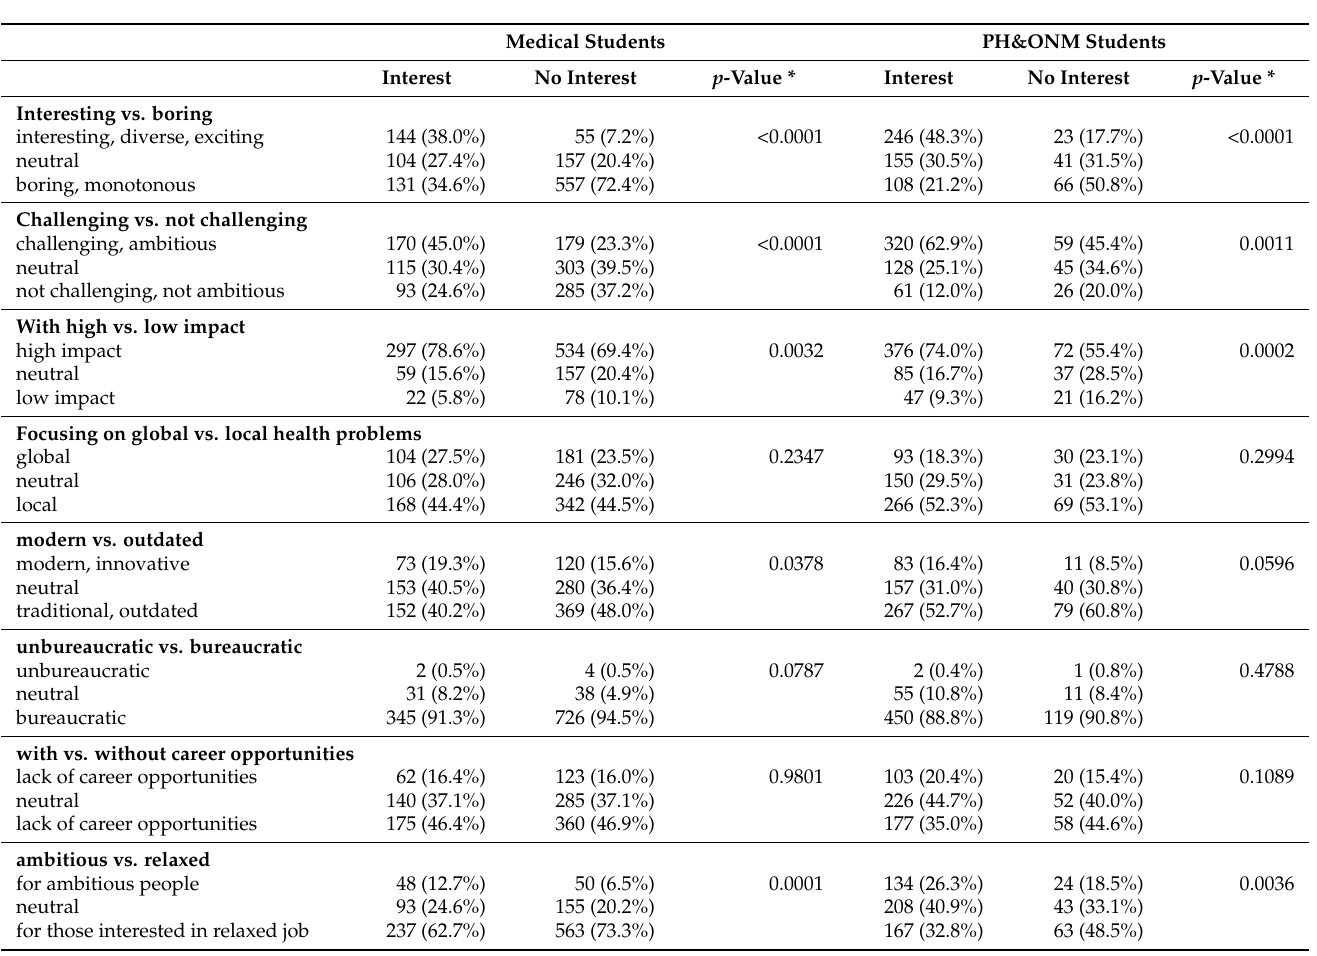
Table A5. Polarity profile: Characteristics associated with an activity in the PHS: Absolute and relative proportion of grouped responses by field of study and PHS interest in wave 1 and wave 2, OeGD-Studisurvey. Medical Students PH&ONM Students Interest No Interest p -Value * Interest No Interest p -Value